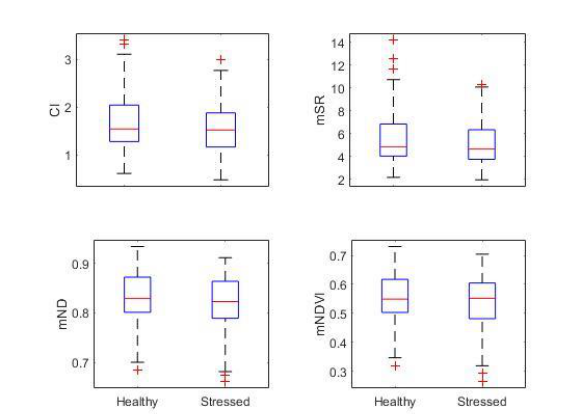
Figure 7: Boxplot showing the data used in the two-sample Kolmogorov-Smirnov goodness-of-fit hypothesis test not significantly proving differences between stressed and healthy trees at leaf